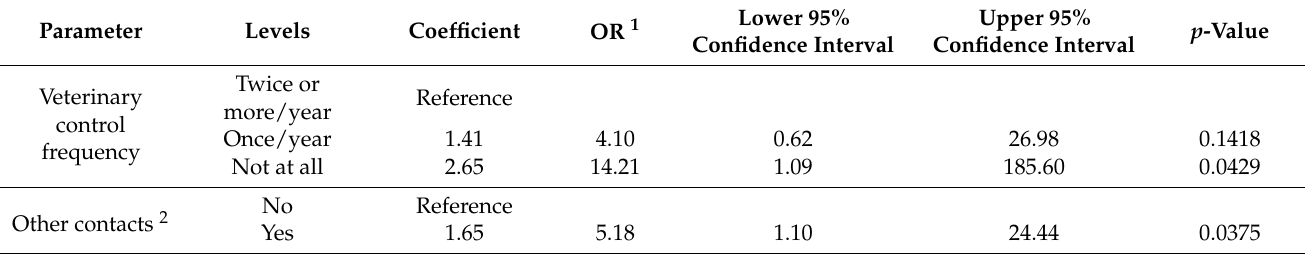
Table 3. Results of the multivariable conditional logistic regression model in a matched case-control study on African swine fever in domestic pigs in Lithuania in